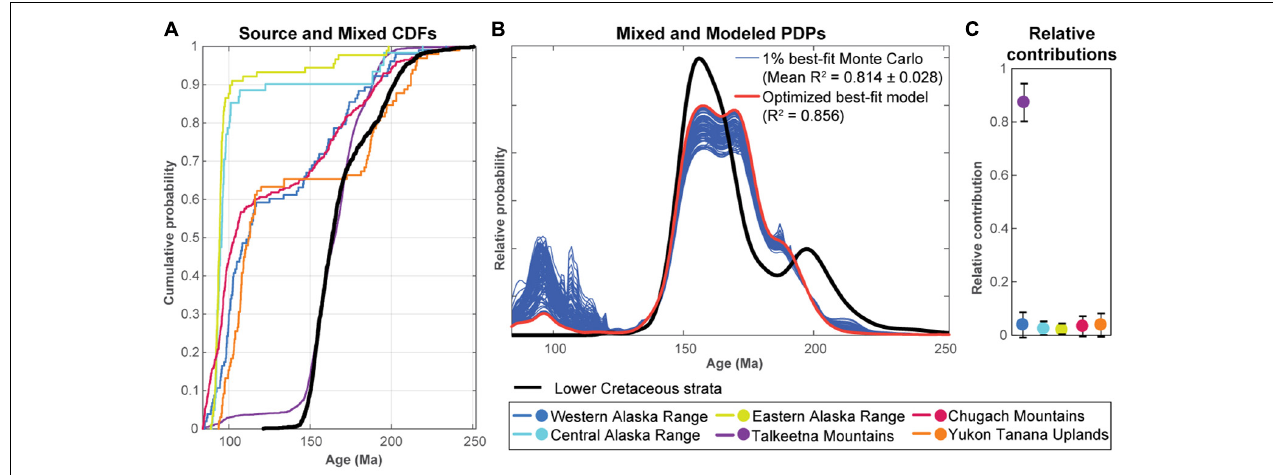
FIGURE 3 | Model results for Lower Cretaceous strata showing (A) cumulative density functions for the basin strata and potential source regions, (B) probability density plots of the basin strata (black), 1% best-fits from the Monte Carlo inverse model (blue), and optimized best-fit forward model (red), and (C) plot of relative contributions from each of the potential source regions produced from the optimized best-fit model.